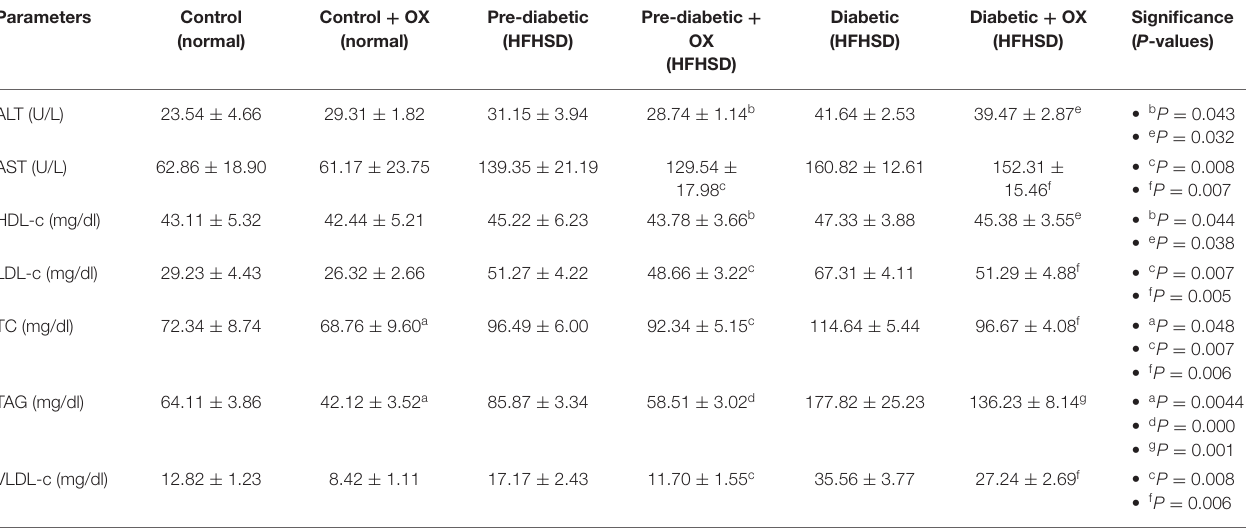
We analyzed creatinine (mg/dl) and albumin (g/dl) in rat sera. prediabetic, and diabetic rats after they were given oxytocin